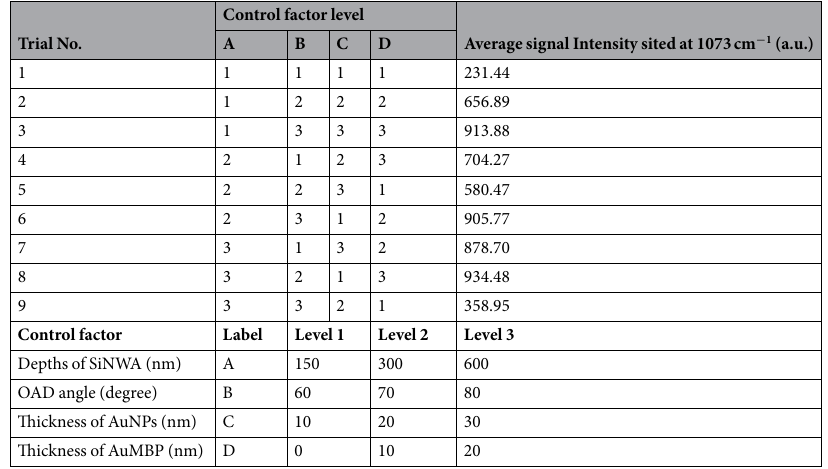
Table 1. The Taguchi L9 orthogonal table with four experimental parameters: (A) Depths of SiNWA, (B) OAD angle, (c) Thickness of AuNPs, (D) Thickness of AuMBP and the corresponding Raman signal intensity for each